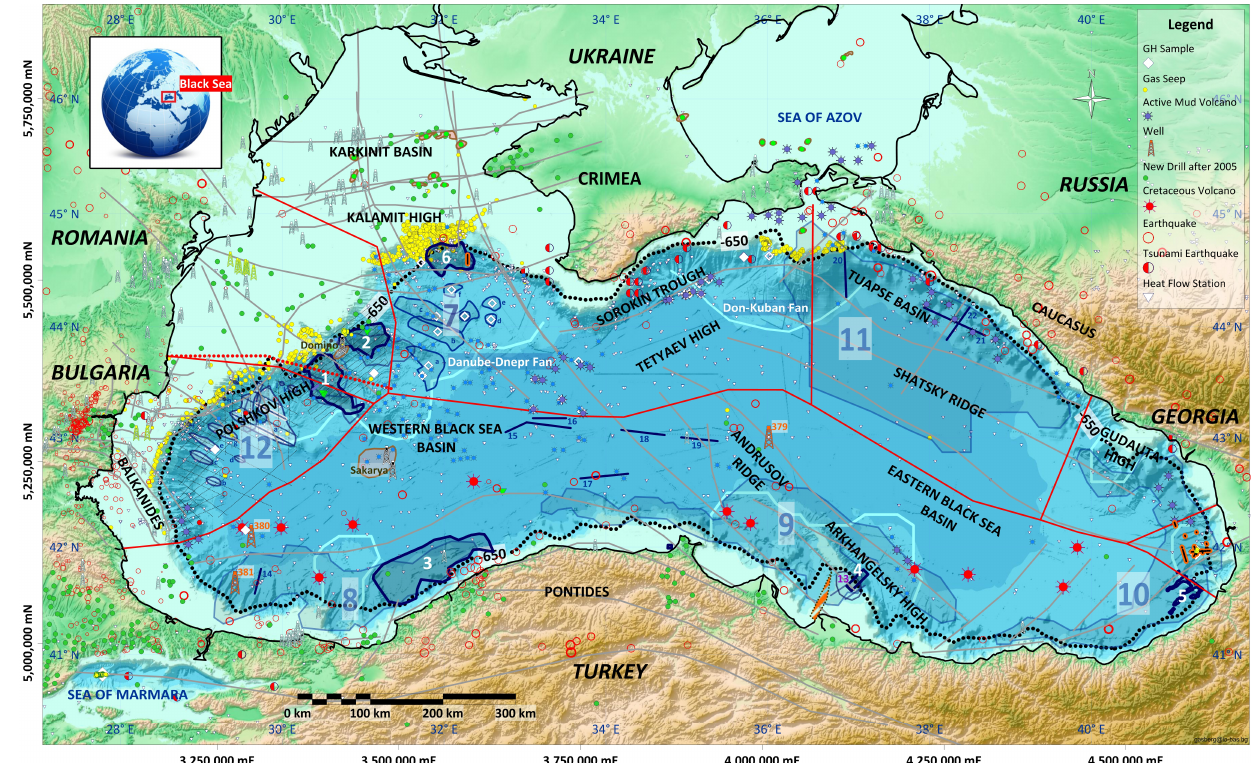
Figure 1. Black Sea gas hydrates and related objects (References in Table 1). Black Sea gas hydrate stability zone (GHSZ) lateral boundary for methane hydrates (approximated with the isobath 650 m); 6 GHDs (numbered BSR areas; the description in the text); 6 areas and 10 2D seismic lines with BSRs; 34 stations with GHs in the sediment samples; 54 faults; 2091 gas seepages; 52 active mud volcanos; 121 stations with mud breeches in the sediment samples (potential mud volcanos not proved with geophysical methods); 11 Cretaceous volcanos; 746 earthquakes (M 2-6); 36 historical earthquakes with tsunami; heat flow stations: 3 DSDP (Deep Sea Drilling Project), 4 Ifremer with 70 m long gravity corer, 2378 with heat flow probes; 7 EEZs; 15 BG drills and production platform Galata; 7 RO platforms; 216 drills after 2005; 2 largest gas fields: Sakarya, TR, 405 bcm and Domino, RO, 80 bcm; seismic lines from 2 cruises: MSM34 in the BG and RO EEZs, SUGAR project; Halliburton GS 1992 in the BG EEZ. According to Tari and Simmons [20]; 2 basin ridges (Andrusov and Shatsky), 5